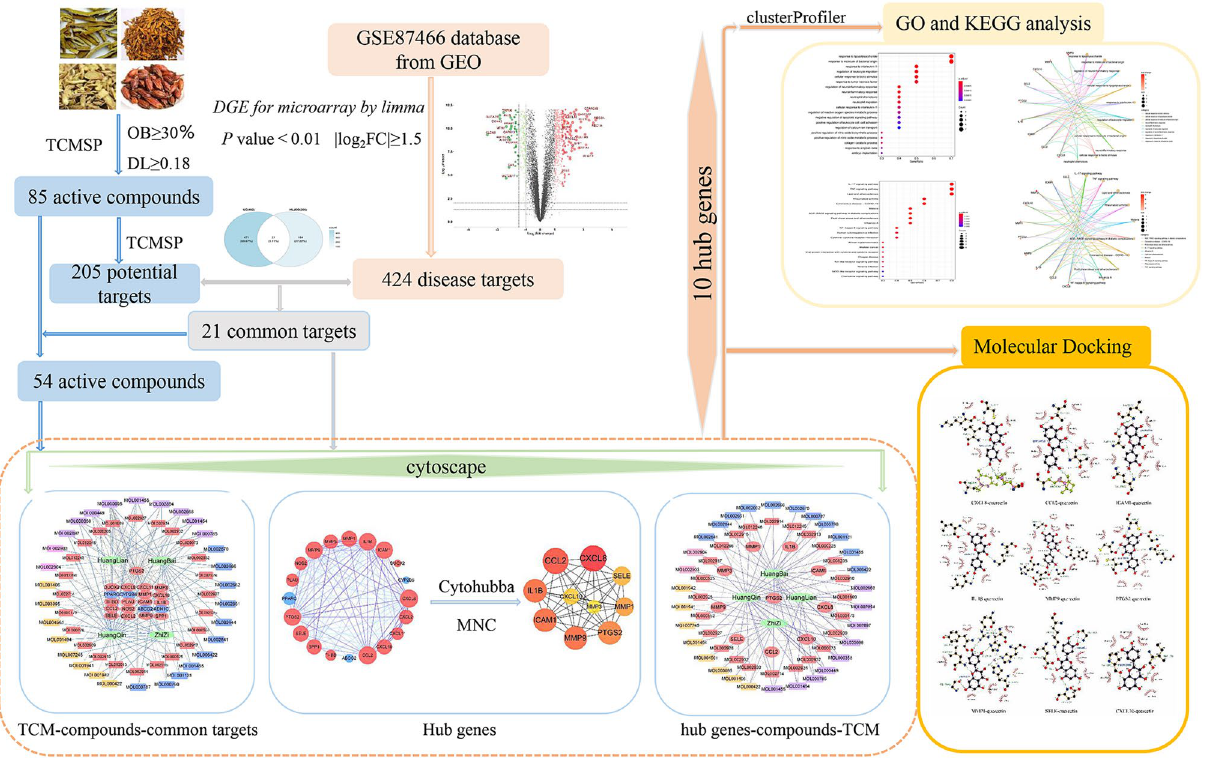
Figure 1. The flowchart of the analysis procedures of the